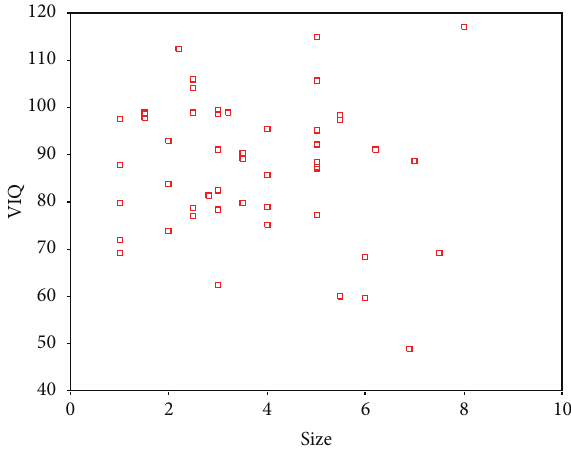
Figure 8: Partial correlation analysis showed a negative relation between tumor size and VIQ in the intracerebral subgroup. Corre- lation coefficient was − 0.280 ( 𝑃 = .047 ).